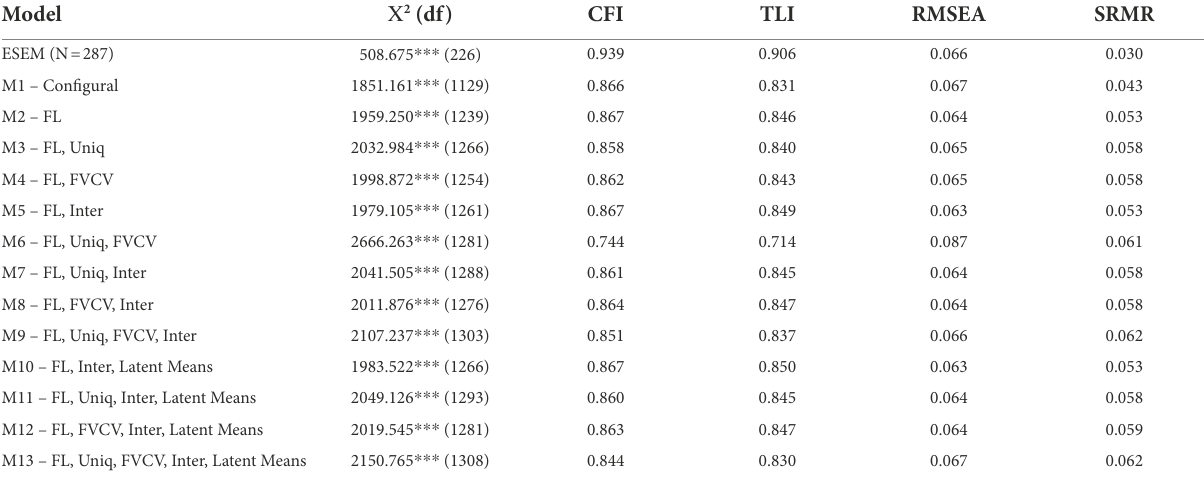
TABLE 10 ESEM time invariance analyses, Study 2. Model